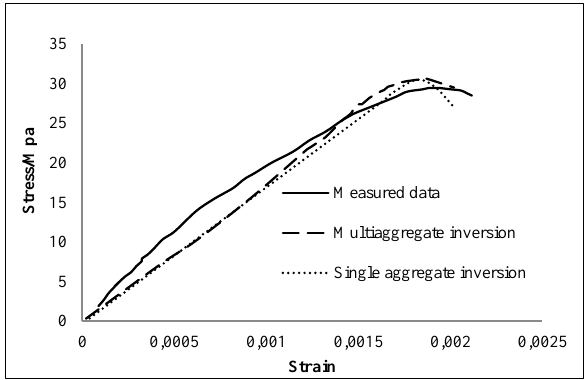
Figure 3: Sensitivity analysis of parameters Figure 4: Comparison of stress-strain